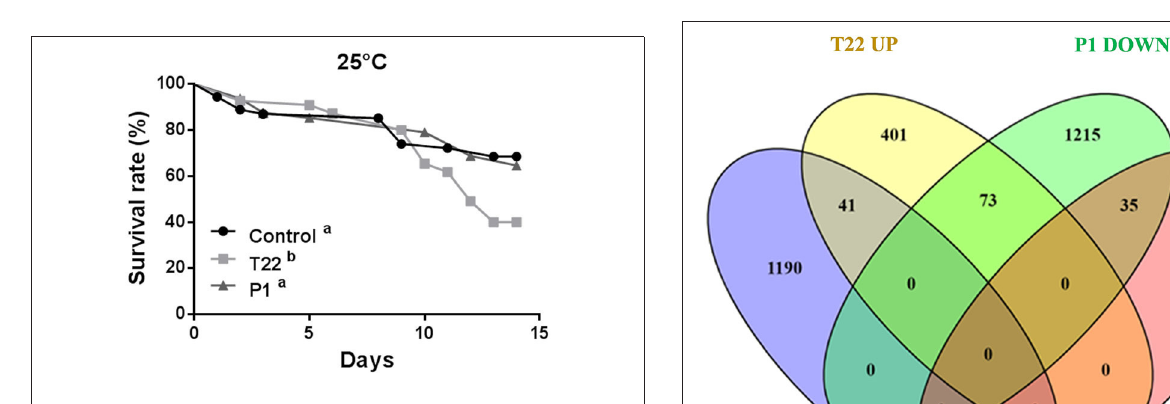
FIGURE 7 | Aphid survival rate at 25 ◦ C. Macrosiphum euphorbiae reared on T22-tomato showed higher mortality compared to aphids on P1- and Control-tomato plants. Different letters indicate a significant difference (Log-rank test, P < 0.001).